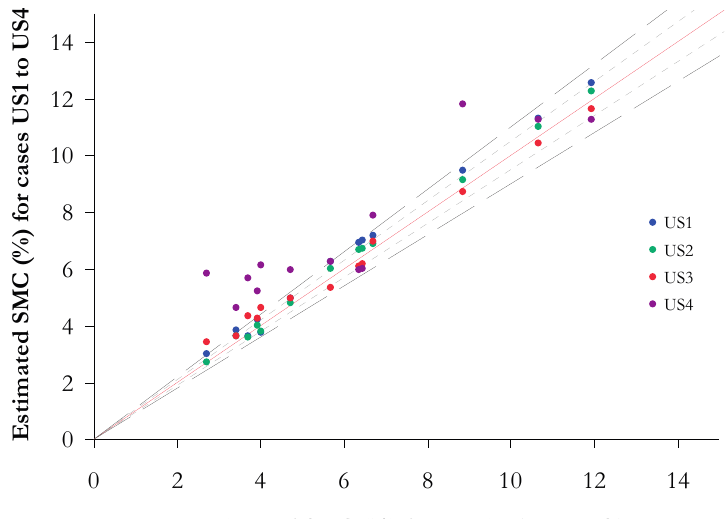
Figure 11. Convex envelope method—Representation of the SMC estimated for the